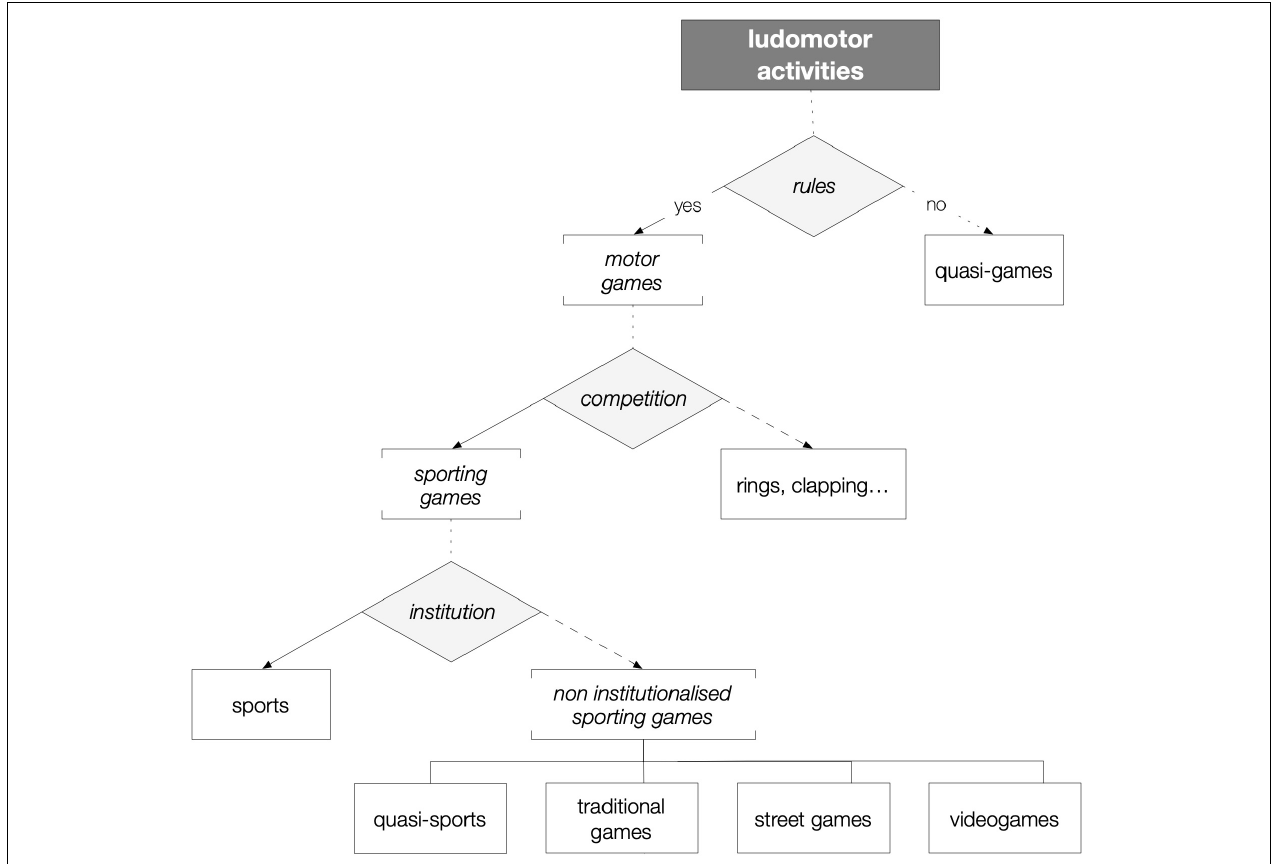
FIGURE 1 | System of categories of ludic motor situations (Parlebas,